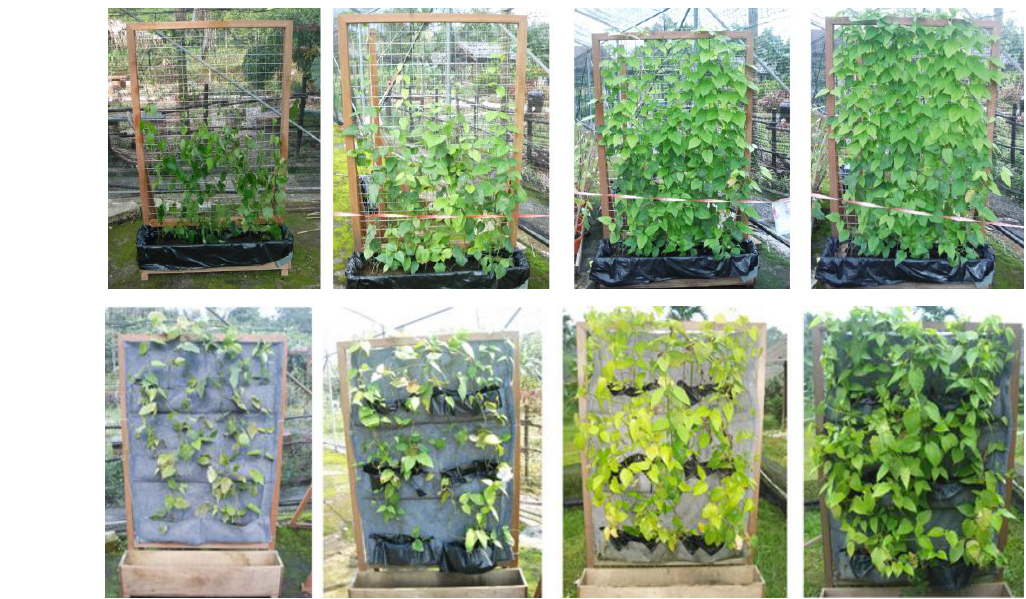
Fig. 2. Green facade trellis and plant growth (a), and living wall trellis and plant growth